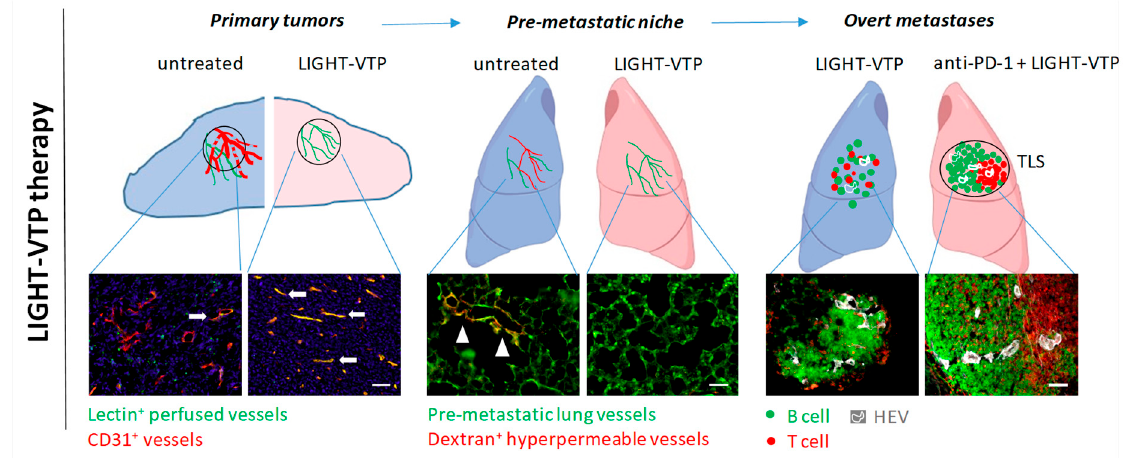
Figure 1. LIGHT-VTP therapy has distinct intra-tumoral effects at different stages during metastatic progression. Left, LIGHT-VTP therapy normalizes primary tumor vessels and improves vessel integrity and tumor perfusion, which also limits tumor cell intravasation into the circulation (30); arrows indicate well perfused vessels in yellow (overlay of CD31 + blood vessels (red) with i.v.-injected FITC-lectin (green) as surrogate marker for perfusion). Middle, LIGHT-VTP therapy reverses the hyperpermeability of pre-metastatic lung vessels (green) as measured by extravasated high molecular dextran (red). Arrow heads illustrate hyperpermeable areas in tumor-conditioned, untreated lung. In correlation with reduction of hyperpermeability, LIGHT-VTP treatment also reduces ECM (fibronectin) deposition and extravasation of circulating tumor cells (30). Right, in overt metastases, LIGHT-VTP therapy normalizes blood vessels, induces HEVs and small immature T and B cell clusters. LIGHT ‐ VTP sensitizes to anti ‐ PD ‐ 1 checkpoint inhibition and double treatment induces mature TLS with distinct T cell (red) and B cell (green) zones, and HEVs (white). Scale bars, 50 μ m.